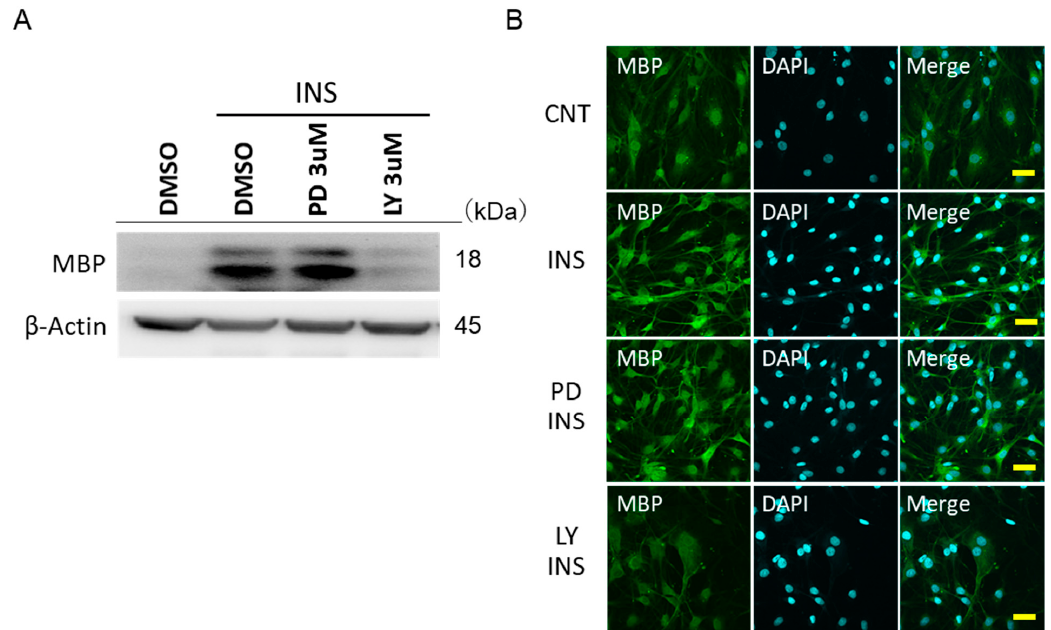
Figure 5. Data on insulin-stimulated myelin basic protein (MBP) expression by various inhibitors. ( A ) Western blot data showing the expression of MBP by insulin stimulation and the effect of LY294002 and PD98059 on MBP. The results of one of three experiments with similar results are shown. * p < 0.05 versus insulin (DMSO control). ( B ) Immunofluorescence-stained image of MBP. Green indicates MBP and blue indicates DAPI (Bar = 100 μ m).